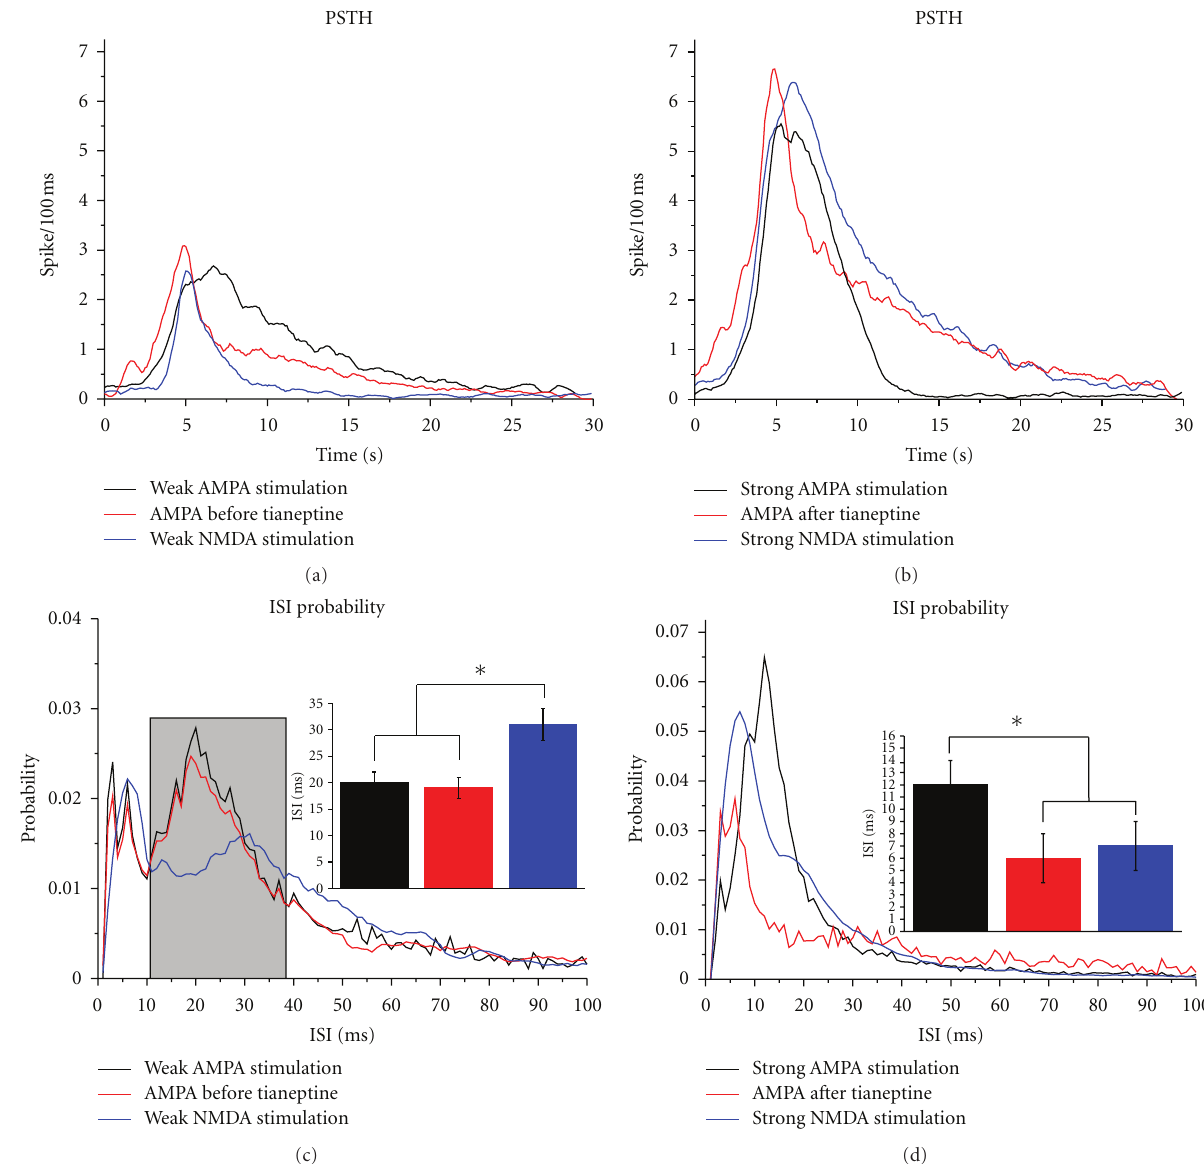
Figure 2: PSTH and ISI probability profiles of di ff erent spike trains. There is no di ff erence between the PSTHs of spike trains evoked by weak excitation (a); in contrast, strong AMPA-evoked spiking activity decayed faster than strong NMDA or AMPA after tianeptine spike trains (b). ISI probability distributions of weak excitation evoked spike trains (c). Inset shows the ISI values for the second probability peak (marked with a grey rectangle). ISI probability distributions of strong excitation evoked spike trains (d). Inset shows the ISI values for the maximal probabilities. Note the di ff erence between strong AMPA and AMPA after tianeptine. Colors in the insets correspond to the colors in the main figure. Asterisks denote significant di ff erences at P ≤ 0 .